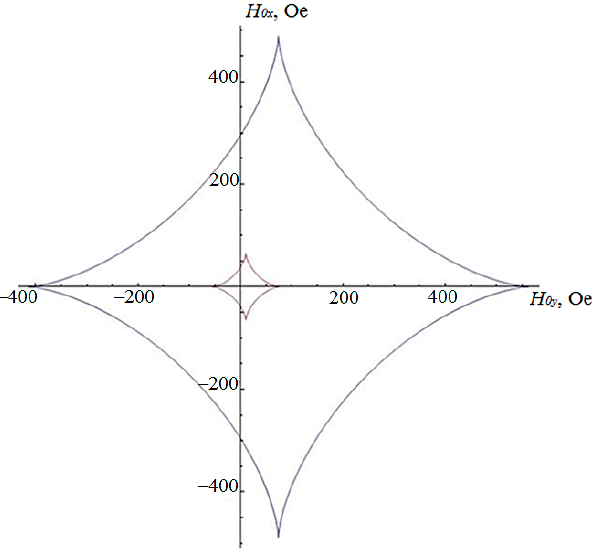
Figure 3. Stoner–Wohlfarth curves for two free magnetic layers (FLs) of the MTJ with ellipsoid semi-axes of a = 3 µ m and b = 1 µ m (inner curve); and a = 0.3 µ m and b = 0.1 µ m (outer curve).